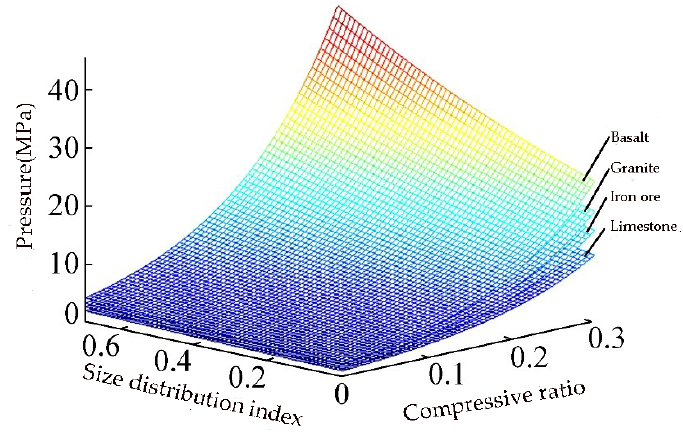
Figure 4. Multi ‐ material crushing pressure model. Figure 4. Multi-material crushing pressure